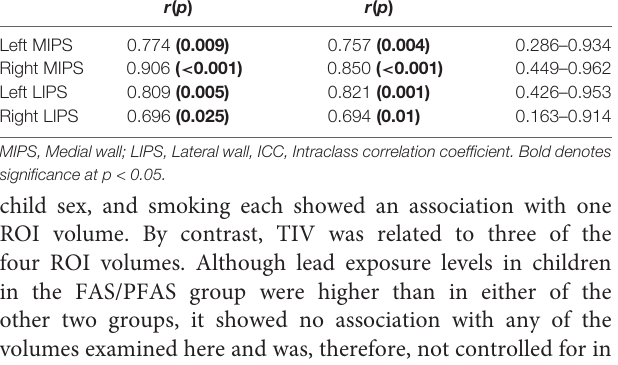
TABLE 2 | Intra-rater reliability of the ROI volumes for 10 randomly selected participants. Pearson